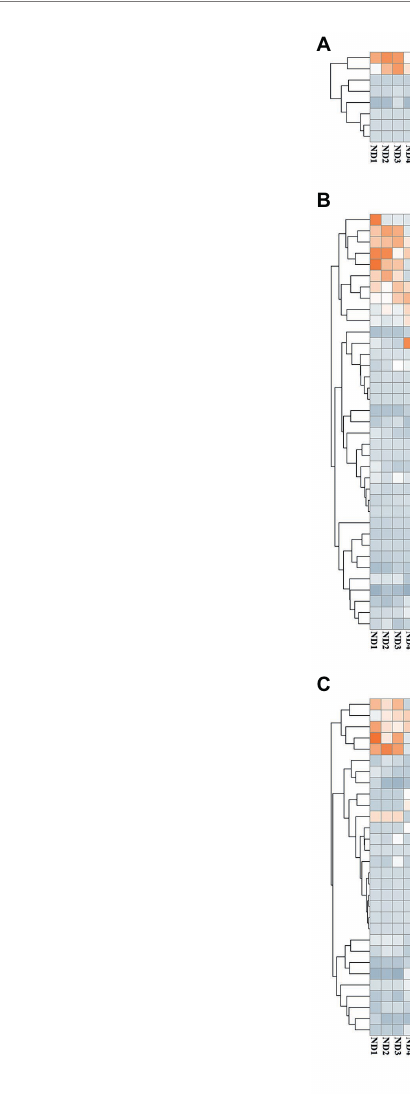
FIGURE 7 Effect of BCAAs supplementation on the gut microbiota composition. Hierarchically clustered heatmaps of gut microbiota that were significantly altered (ND vs. ND + BCAAs, ND vs. HFD, HFD vs. HFD + BCAAs, q ≤ 0.05 after correcting for the value of p ) in the (A) ileum, (B) cecum, and (C) colon at the genus level. The scale bar shows the standardized Z -value of the microbial relative abundance. Red and blue colors indicate higher and lower mean expression, respectively ( n = 4 for the ND, ND + BCAAs, and HFD + BCAAs groups, n = 6 for the HFD group of biologically independent